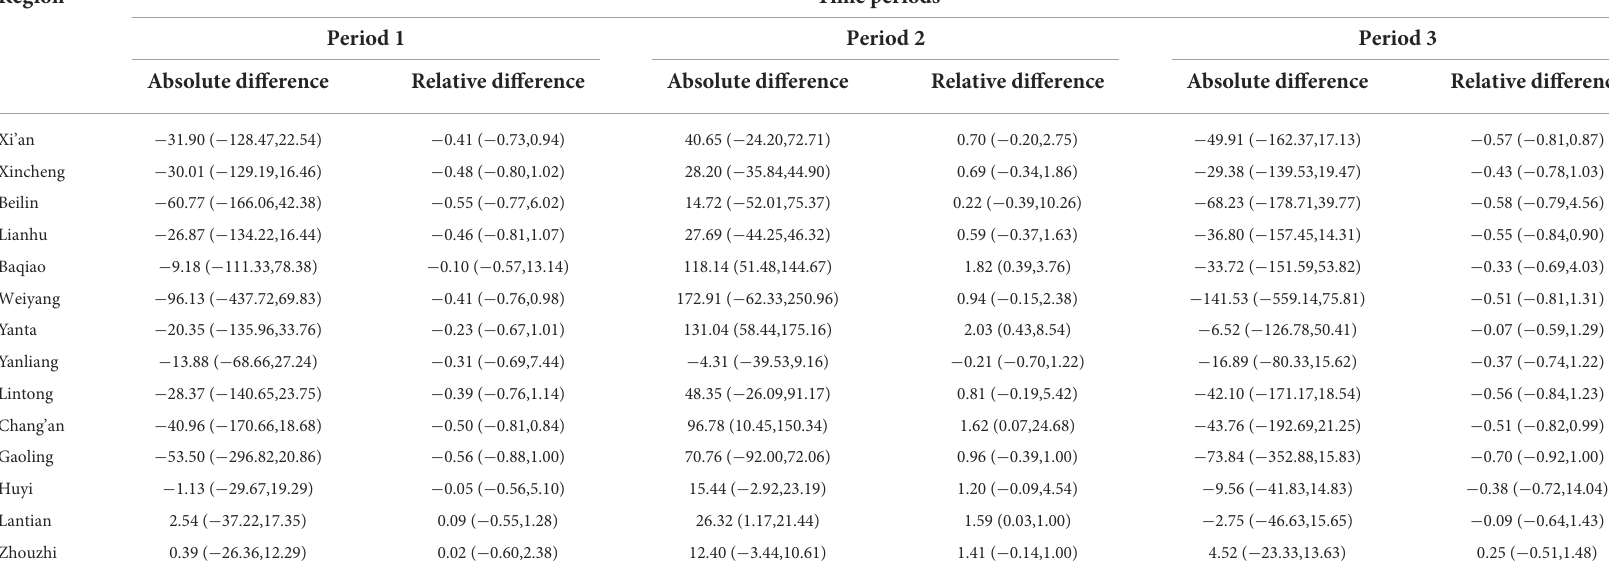
TABLE 1 Cumulative differences between predicted (Bayesian structural time series model) and reported incidence of infectious diarrhea during the three post-COVID-19 time periods in Xi’an overall, and in 13 different counties of Xi’an. Region Time periods Period 1 Period 2 Period